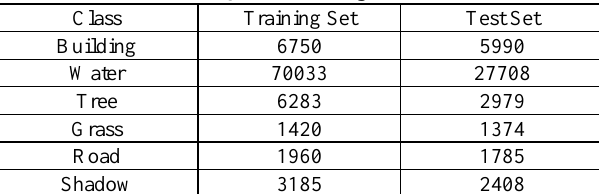
Table 2. Number of the training and test samples for the